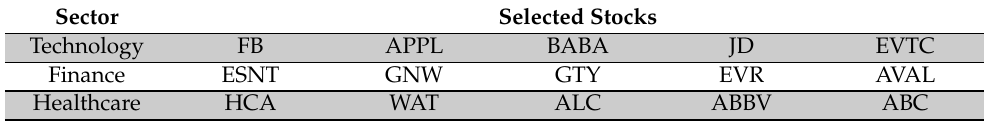
Table 5. The distribution of the 15 selected stocks across 3